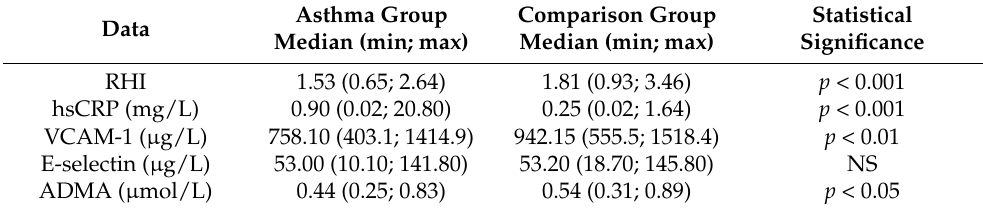
Table 5. RHI and biomarker values. Figure 1. BMI in asthmatics vs. HI. Boxes indicate the inter-quartile range. Horizontal lines within boxes indicate medians. Whiskers extend to the highest or lowest values. BMI: body mass index; HI: healthy individuals .